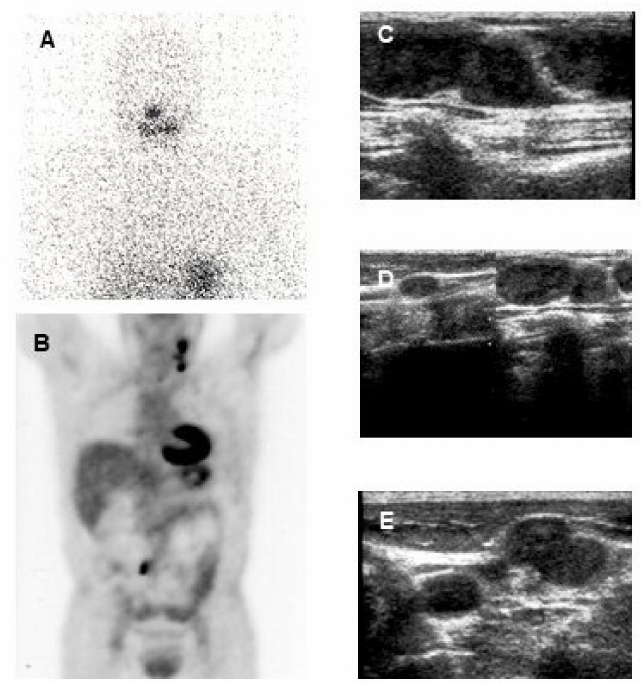
Figure 5. 37-year-old woman with a papillary thyroid cancer (tall cell variant) with a post-operative TSH-stimulated serum thyroglobulin (Tg) level of 230 ng/mL. Post-therapy 131 I whole-body scan ( A ) did not show any area of increased uptake. 18 F-FDG PET-CT ( B ) evidenced multiple areas of increased uptake in the left latero-cervical region and homogeneous cardiac 18 F-FDG uptake (that is not an infrequent finding, also in patients without overt cardiac disease). Ultrasound ( C,D,E ) evidenced multiple suspicious lymph-nodes in the left latero-cervical region, with round shape, loss of echogenic hilus and micro lobulated margins. At fine needle aspiration cytology confirmed lymph node metastases from the papillary thyroid cancer and the Tg concentration was elevated (3800 ng/mL) in the aspirate